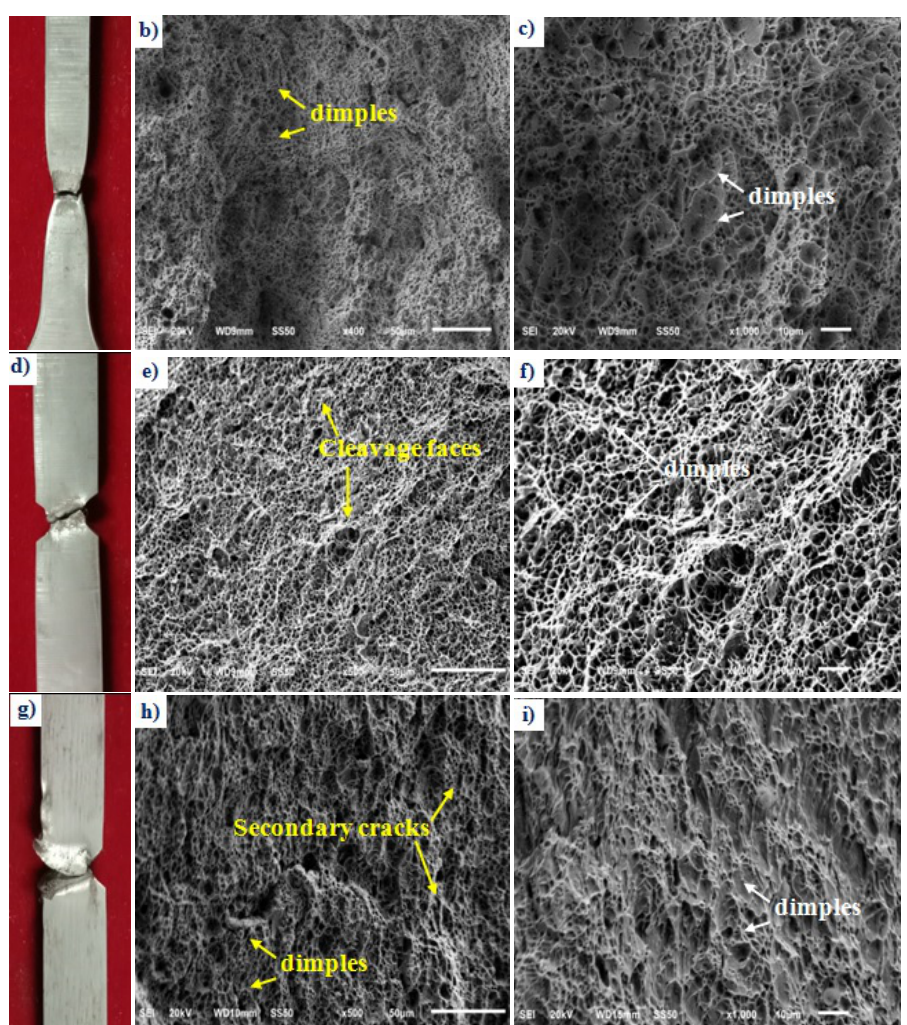
Figure 11: SEM fractographs of the specimen extracted from bottom region, (a-c) smooth tensile, (d-f) notch tensile and (g-i) charpy